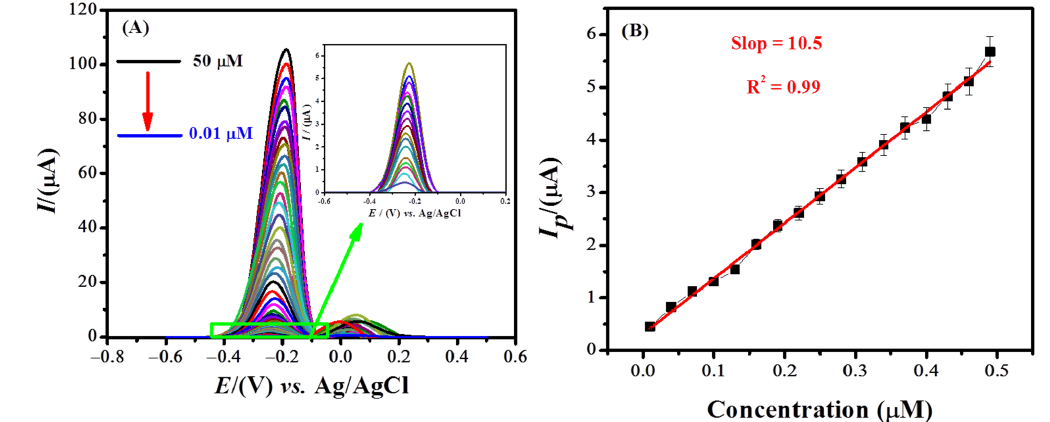
Figure 6. ( A ) Square wave voltammograms of the MB solution of different concentrations using NH 2 - f MWCNTs/GCE under optimized conditions (0.1 M PBS (pH = 6.0), deposition potential = − 0.3 V, deposition time = 60 s). ( B ) Calibration plot in a concentration range of 0.5 µ M to 0.01 µ M. Table 1. Methylene blue sensors and their performance parameters.